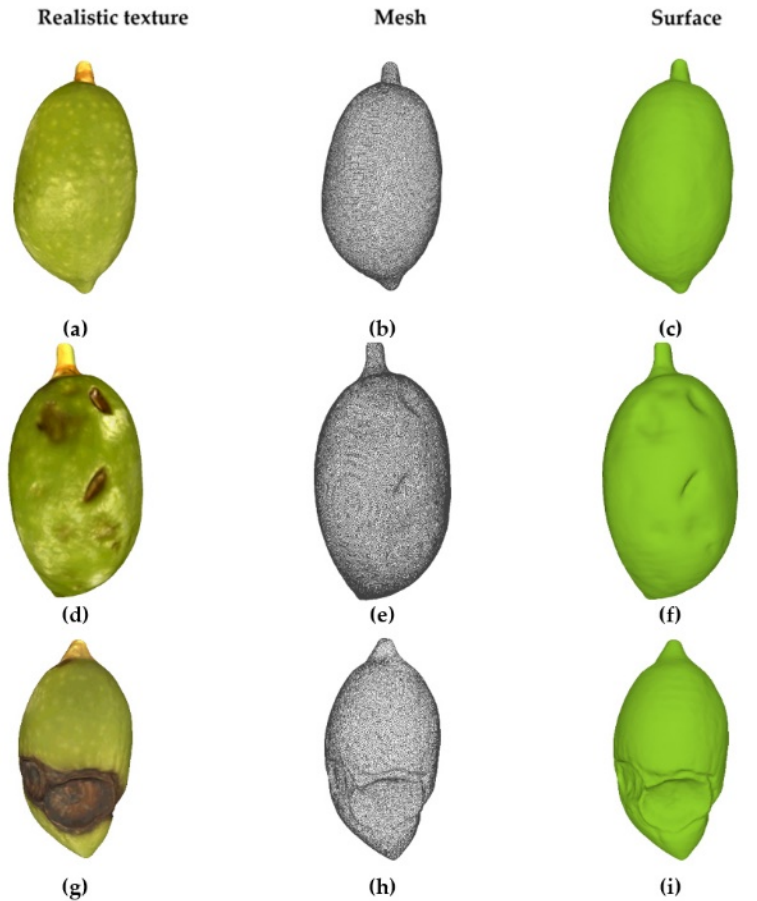
Figure 20. Examples of Picudas variety olives: ( a , d , g ) 3D mesh texturing; ( b , e , h ) mesh, and ( c , f , i ) surface.